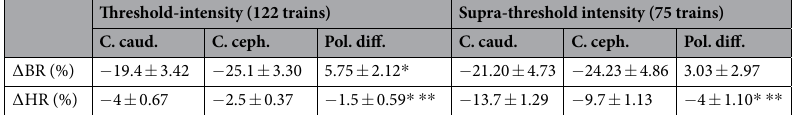
Table 1. Mean ( ± SEM) afferent (percent change in breathing rate, ∆ BR) and efferent (percent change in heart rate, ∆ HR) responses to the 2 polarities, and mean pair-wise polarity difference (cathode caudad - cathode cephalad), for trains of stimuli with intensities at and above physiological threshold. A single asterisk next to a polarity difference value denotes statistically-significant difference between the 2 polarities, for that physiological response (paired t-test p < 0.01); a double asterisk denotes statistically-significant difference between threshold and supra-threshold intensities, for that physiological response (2-sample t-test, p <